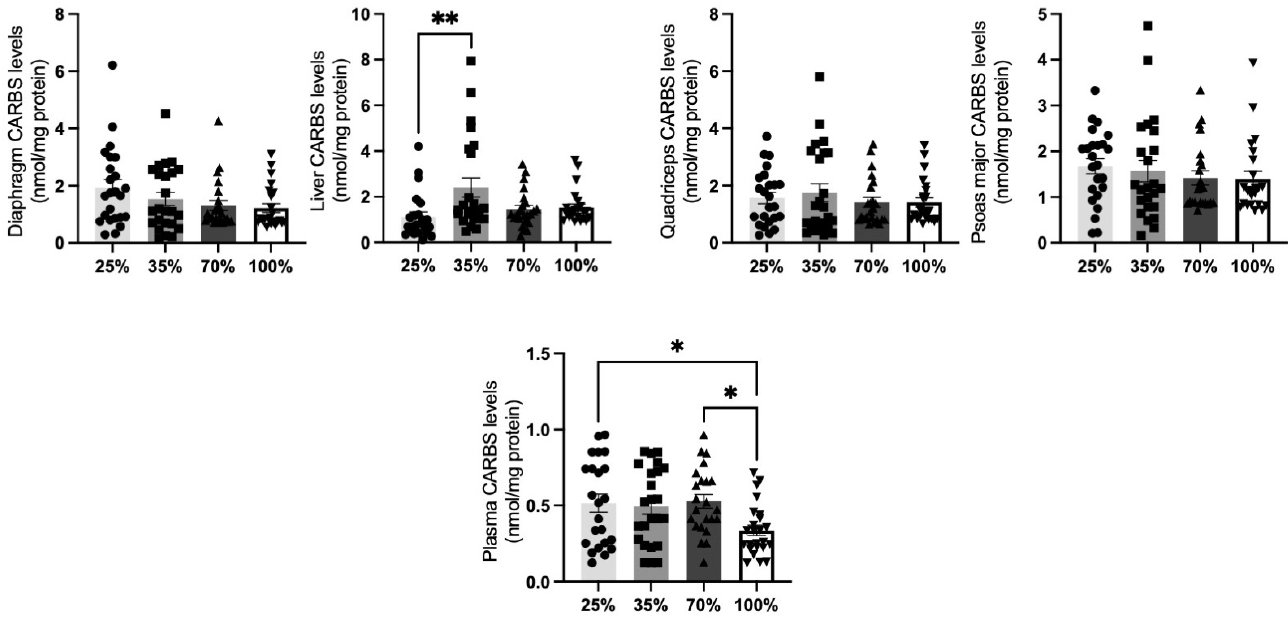
Figure 1. CARBS levels at all 4 d.s. of kids. * denotes significant difference with p < 0.05, *** denotes significant difference with p < 0.001, **** denotes significant difference with p < 0.0001. CARBS levels were reduced only in the blood of the lambs that were at the 100% d.s. ( p < 0.05, Figure 2). Additionally, after an initial increase at 35% d.s., CARBS at the liver of lambs at 70% and 100% d.s. returned to the levels that were observed at the 25% d.s. No other significant change was observed in all other tissues tested.